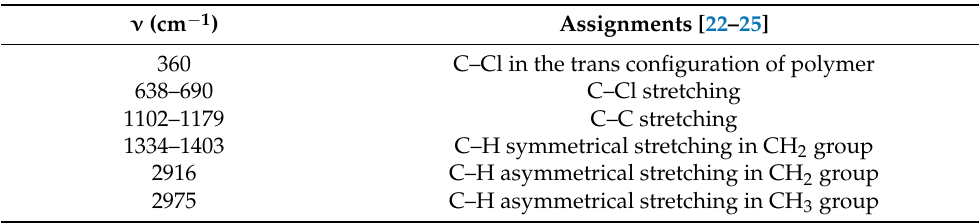
Table 1. Vibrational modes observed by Raman spectroscopy in poly(vinyl chloride) (PVC)